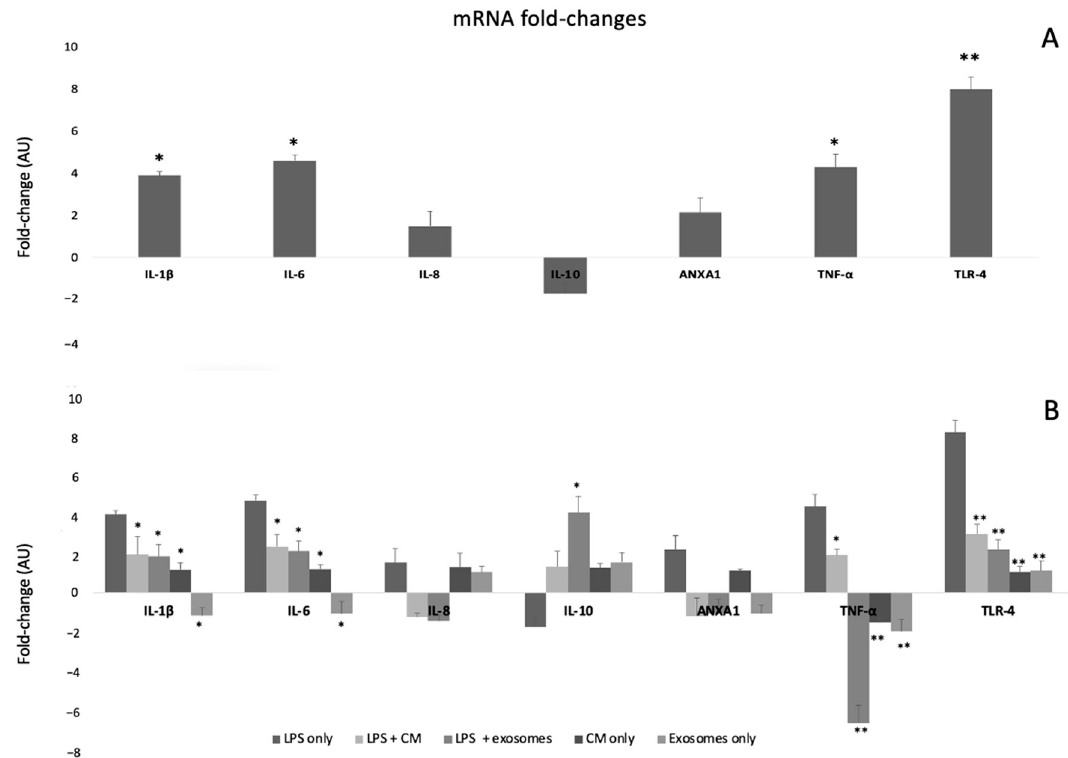
Figure 3. ( A ) Fold changes of genes in SEMF cells that were incubated with LPS compared to cells that received no LPS treatment. The asterisk symbols (*, **) indicate statistical significance ( p < 0.05 and p < 0.01, respectively) using one-way ANOVA compared to cells that were not treated with LPS. ( B ) Fold changes of genes in SEMF cells that were incubated with LPS, LPS + CM, LPS + exosomes, CM (without LPS), or exosomes (without LPS). The asterisk symbols (*, **) indicate statistical significance ( p < 0.05 and p < 0.01, respectively) using one-way ANOVA between cells treated with LPS + CM, LPS + Exosomes, CM, or exosomes and LPS-only treated cells.